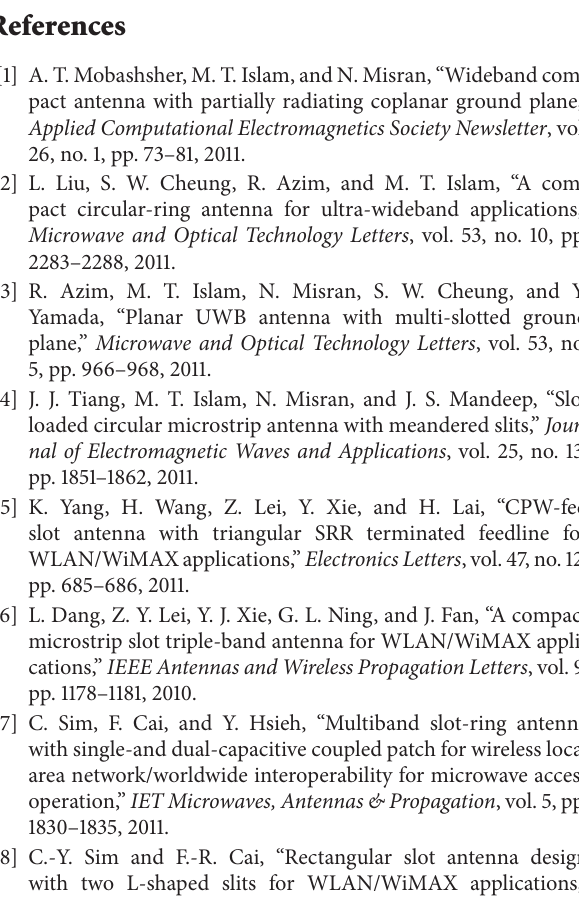
size. Moreover, this antenna is fabricated on an inexpensive FR4; therefore, it is suitable for mass